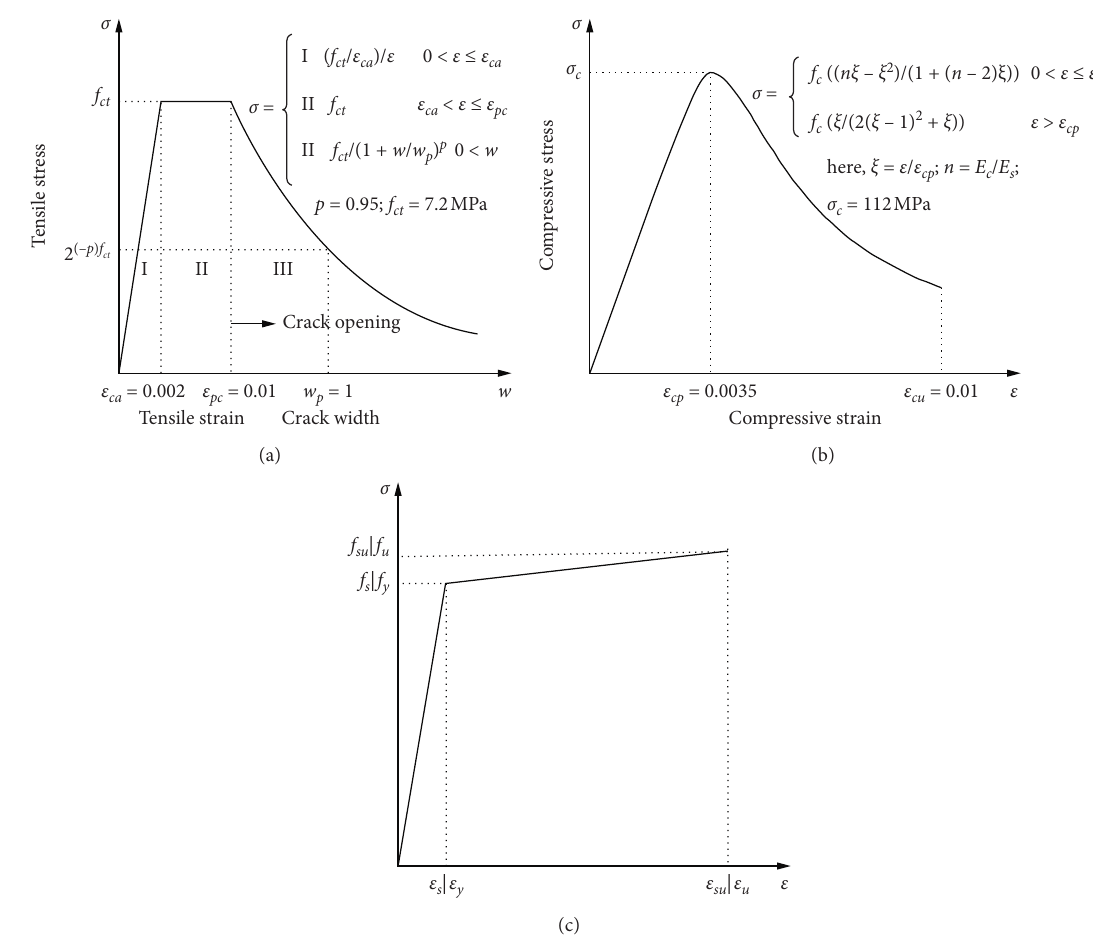
Figure 10: The constitutive model of UHPC in (a) tension [33], (b) compression [34], and (c) steel plate and rebar